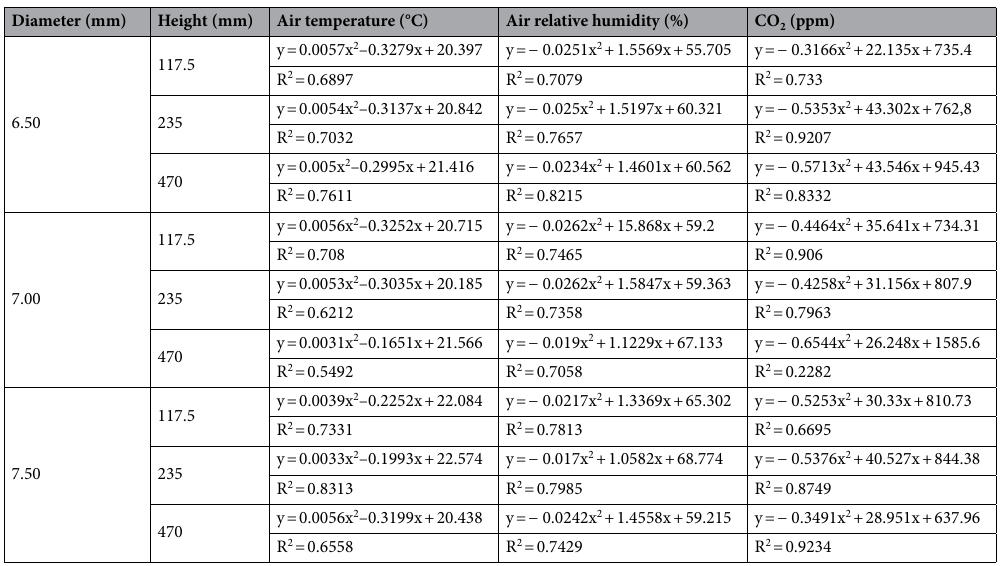
Table 4. Polynomial regression equations for air temperature (°C), air relative humidity (%) and CO 2 (ppm) of corn grain mass at 25% moisture content in tubes with different hole diameters and heights drilling.